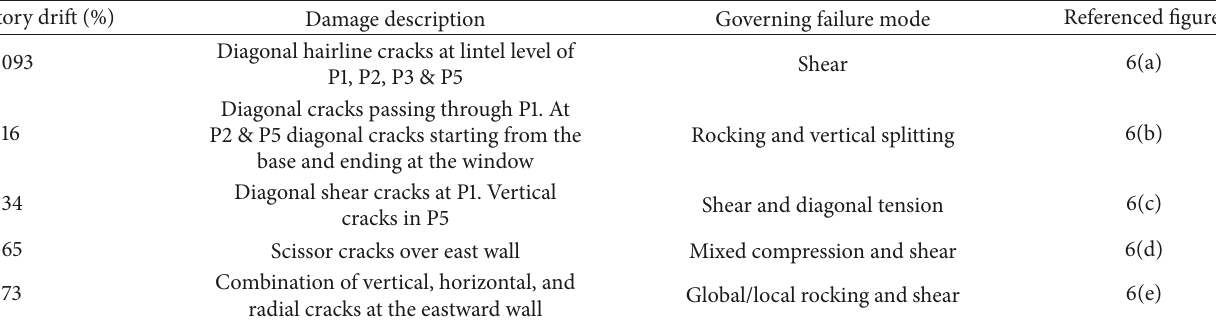
Table 2: Description of damage progression for the original